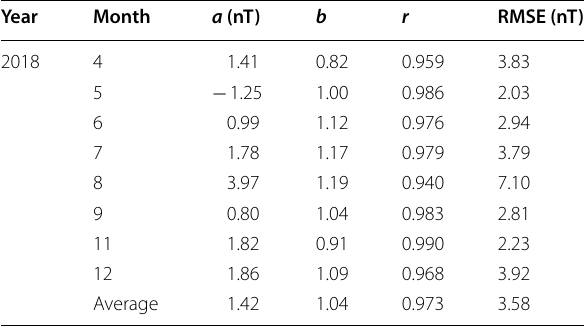
9), November ( m 11), and December ( m 12) in 2018. The bottom panels correspond to the = = =